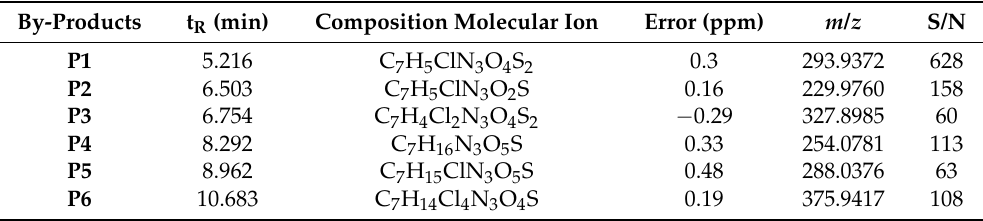
Table 3 Accurate mass measurements obtained by LC ‐ TOF/MS for the by ‐ products after electrochemical oxidation treatment of hydrochlorothiazide.